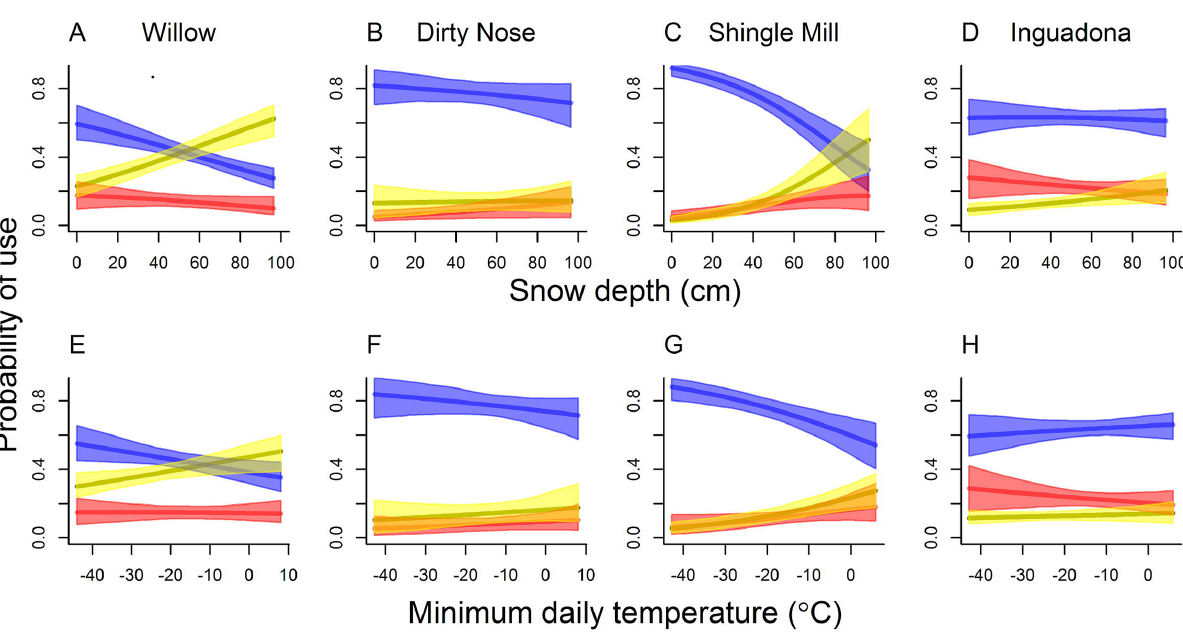
Fig 2. Model-based predicted probabilities of adult ( (cid:21) 1.5 yearsold), female white-tailed deer using dense ( (cid:21) 70%canopy closure, yellow) and moderately dense (40% (cid:20) ×< 70%canopy closure, red) conifer cover, and “other” (here includes conifer with < 40% canopy closure, openings, and hardwoods; blue) during daytime hours (i.e., 0730–1700hr) as a function of snow depth (panels A-D) and minimum daily temperature (panels E-H), for each of four study sites, north-central Minnesota, 1 November–14 May 1993–1994to 2004–2005. Coloredbandsdepict point-wise95% bootstrap confidenceintervals. To generate model-basedresponse curves, we set availabilities of each habitat type to site-specificmean values. Similarly, we set daily snow depths (for bottom panels) and minimum temperatures (for top panels)to